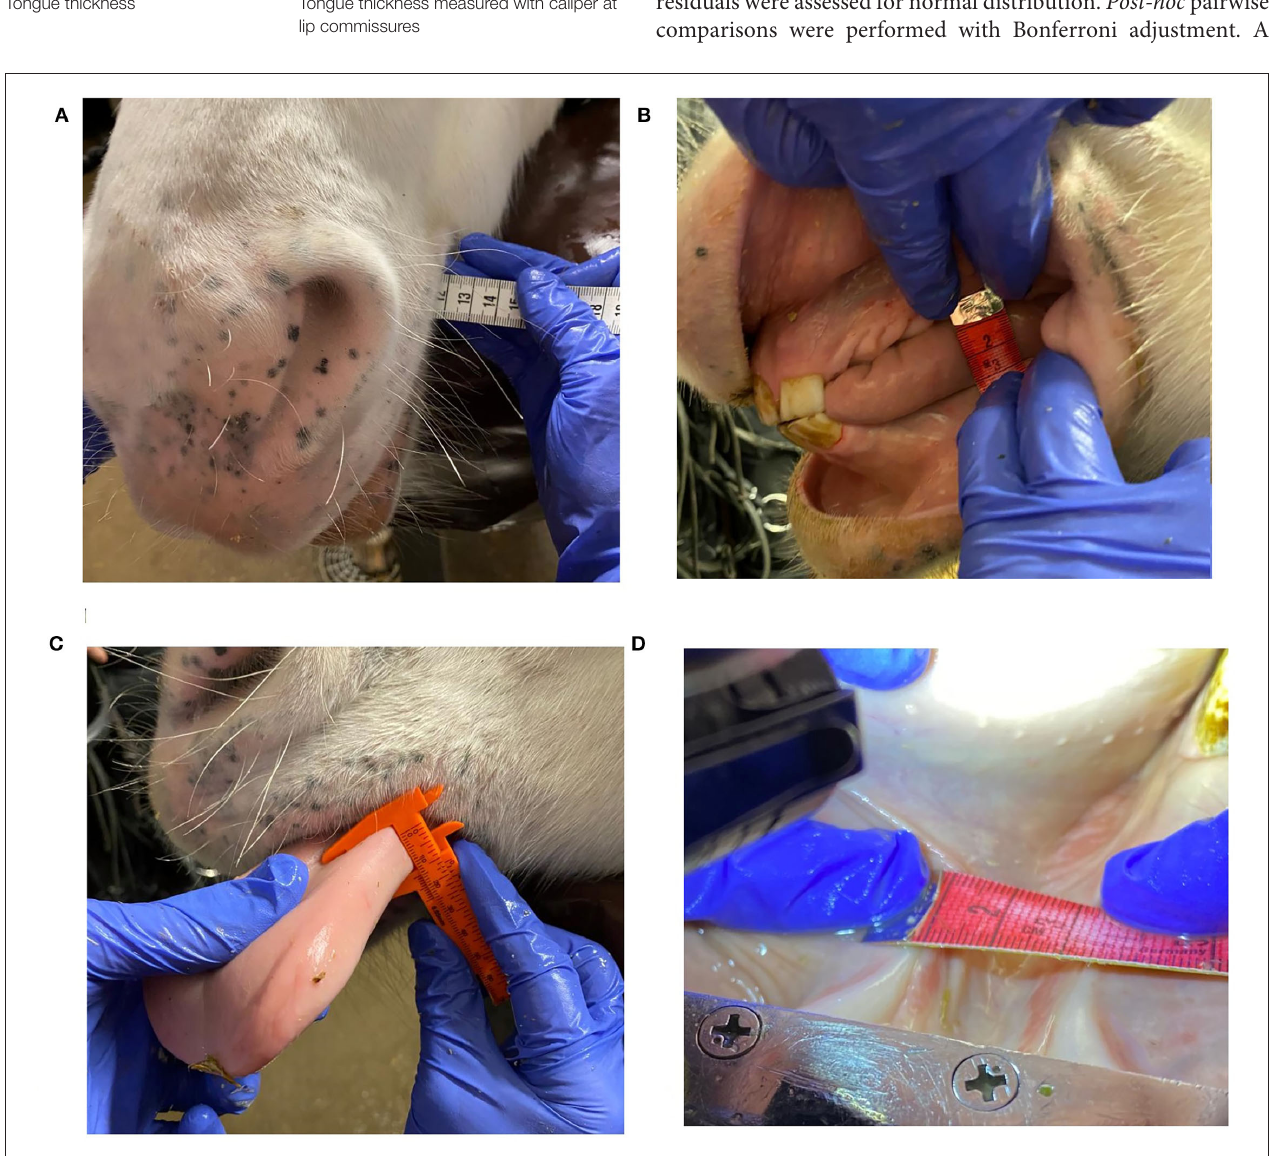
FIGURE 1 | Oral dimension measurements: (A) mouth width, (B) distance between upper and lower jaw, (C) tongue thickness, (D) lower jaw width.